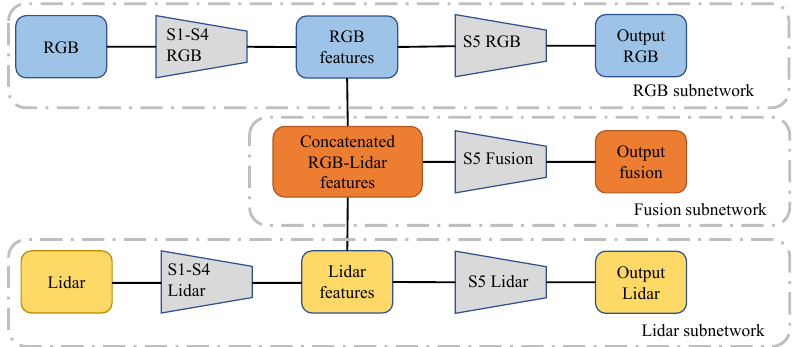
Figure 2. Illustration of the model used in this work. The model can be decomposed into three subnetworks: RGB; lidar; and fusion. The fusion subnetwork receives as input the concatenated features generated by stages S1–S4 of the single modality subnetworks. This corresponds to a late fusion strategy. During a supervised learning step, the output of each subnetwork is used to compute a loss term with respect to a manually generated ground truth. During a semi-supervised step, the fusion subnetwork acts as teacher for the single modality ones. That is, the fusion subnetwork’s output is used as ground truth for computing the losses of the RGB and lidar subnetworks. For co-training, only the single modality subnetworks are considered. In this case, the output relative to one sensor is used as ground truth for the